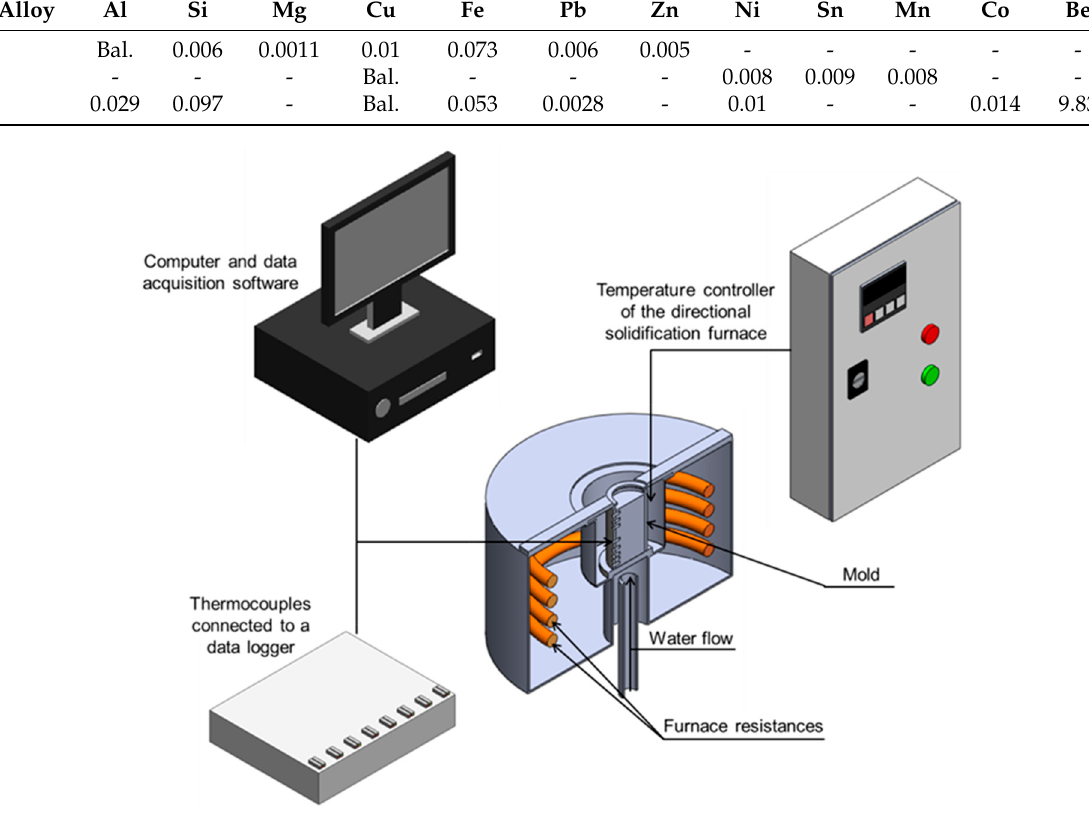
Figure 1. Schematic representation of the water-cooled upward directional solidification apparatus. As schematically represented in Figure 2, longitudinal and transverse samples were extracted from the directionally solidified (DS) castings for microstructural characteriza- tion. The samples were ground with silicon carbide papers from 100 up to 1200 mesh and subsequently polished with diamond paste (1 and 3 µ m). Microstructural spacings measurements were performed on images acquired using an Olympus Inverted Metallurgical Microscope (model 41GX, Olympus, Tokyo, Japan). The eutectic colony/primary dendritic arm spacings ( λ EC / λ 1 ) were measured on transverse samples using the triangle method, while the lamellar ( λ L ) and secondary dendritic arm ( λ 2 ) spacings were quantified using the linear intercept method, λ L in transverse sections and λ 2 in longitudinal